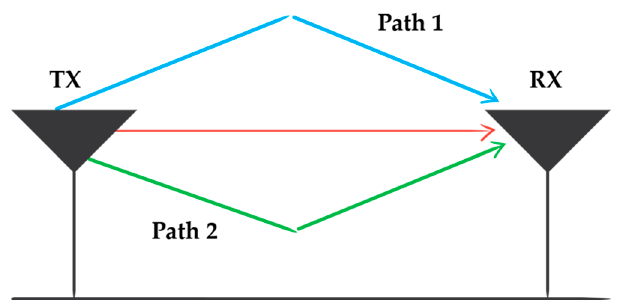
Figure 3. An example of multipath wave propagation between transmitter (Tx) and receiver (Rx).